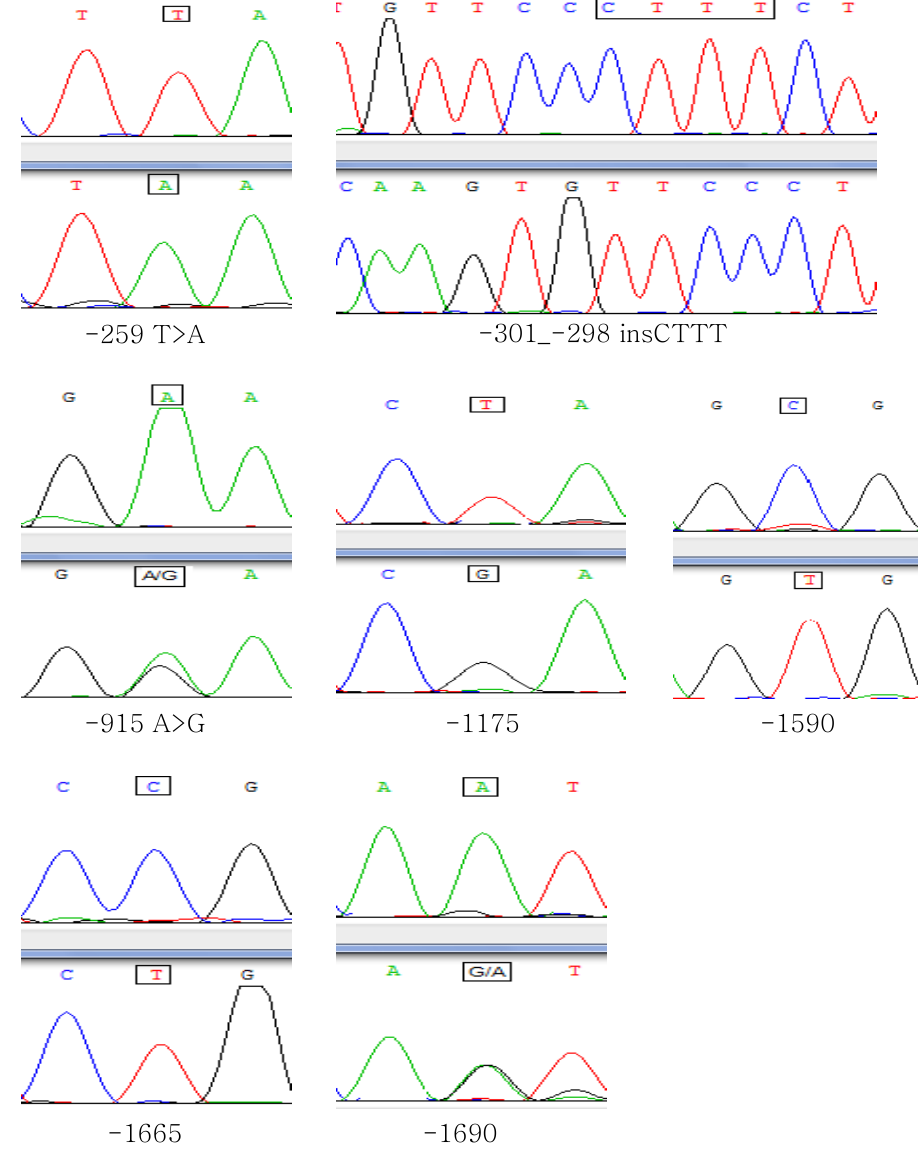
G>A Figure 1. Sequencing results and polymorphic sites found in the promoter region of the bovine PPARGC1A gene in Chinese